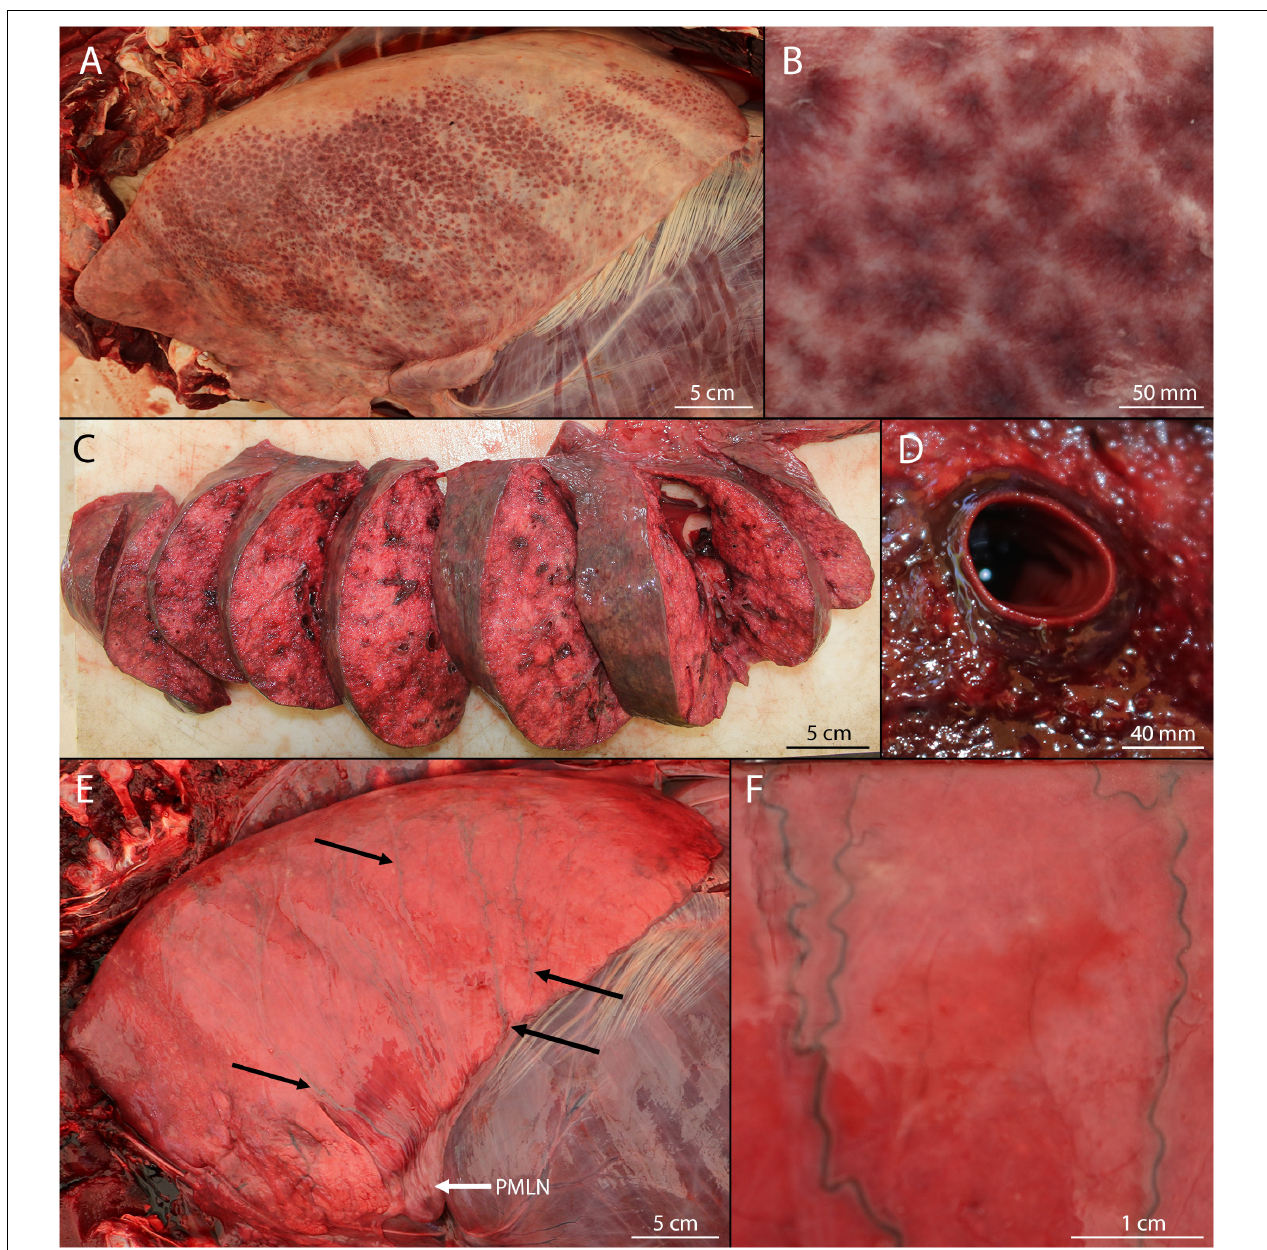
FIGURE 1 | Pulmonary lesions in bycaught bottlenose dolphins. (A) Pulmonary petechiae. (B) Detail of pulmonary petechiae. (C) Pulmonary perivascular edema and/or hemorrhage. (D) Detail of pulmonary perivascular edema and/or hemorrhage. (E) Hemorrhagic lymph draining (black arrows) to the pulmonary marginal lymph node (PMLN; white arrow). (F) Detail of hemorrhagic pulmonary lymph.